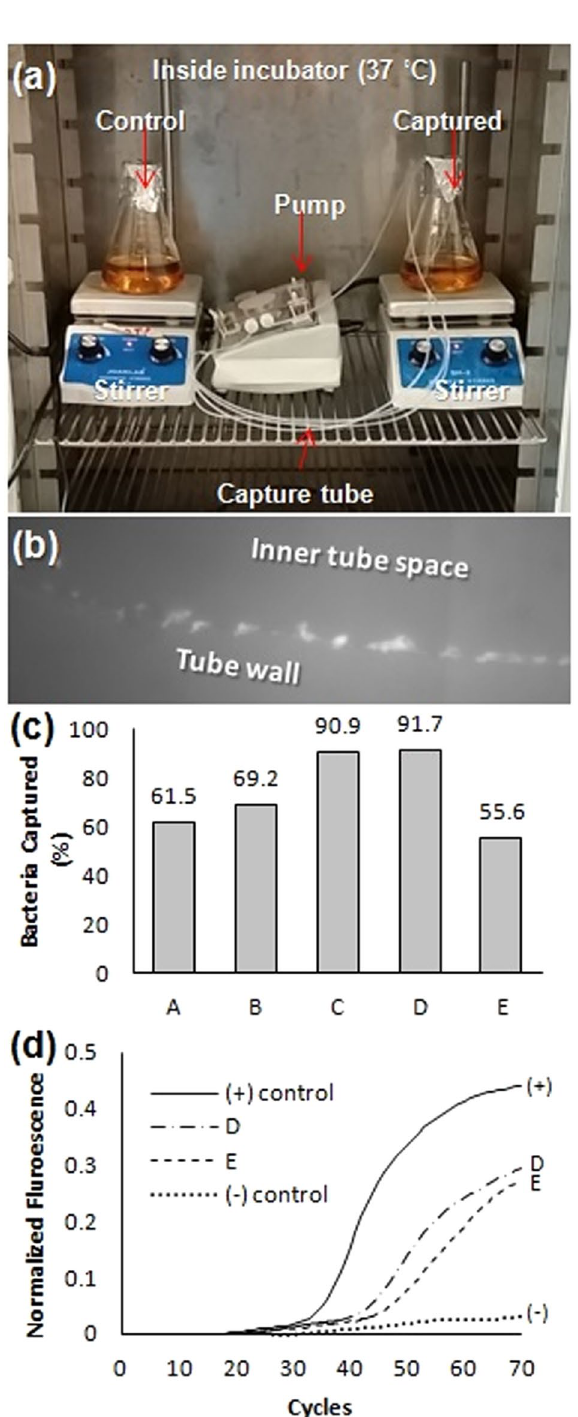
Figure 4. Tube capturing for very low concentration in large sample volume ( a ) Experiment set-up inside an incubator. ( b ) Fluorescence image of captured S . typhimurium on the tube inner walls stained by FITC-labeled primary salmonella antibody (cross sectional view). The stained bacteria were observed aligned on the surface of tube’s inner wall. ( c ) Capturing results under the following conditions: (A) 10 1 CFU (10 CFU) in 100 mL, 7 hours of continuous flow, 120 cm tube. (B) 10 1 CFU in 100 mL, 7 hours of continuous flow, 120 cm tube. (C) 10 1 CFU in 100 mL, 6 hours of continuous flow, 120 cm tube. (D) 10° CFU (1 CFU) in 100 mL, 7 hours of continuous flow. (E) 10° CFU in 250 mL, 7 hours of continuous flow. ( d ) Positive RT PCR detection results from Condition D (DNA extraction by bead beating), and E (DNA extraction by commercial heating